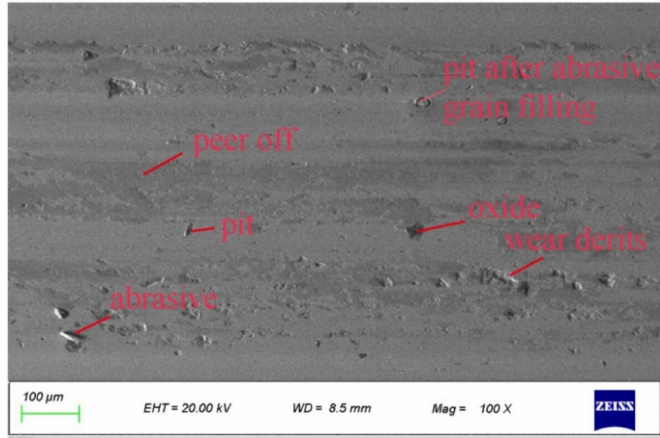
Figure 31. Wear morphology under a normal force of 50 N.